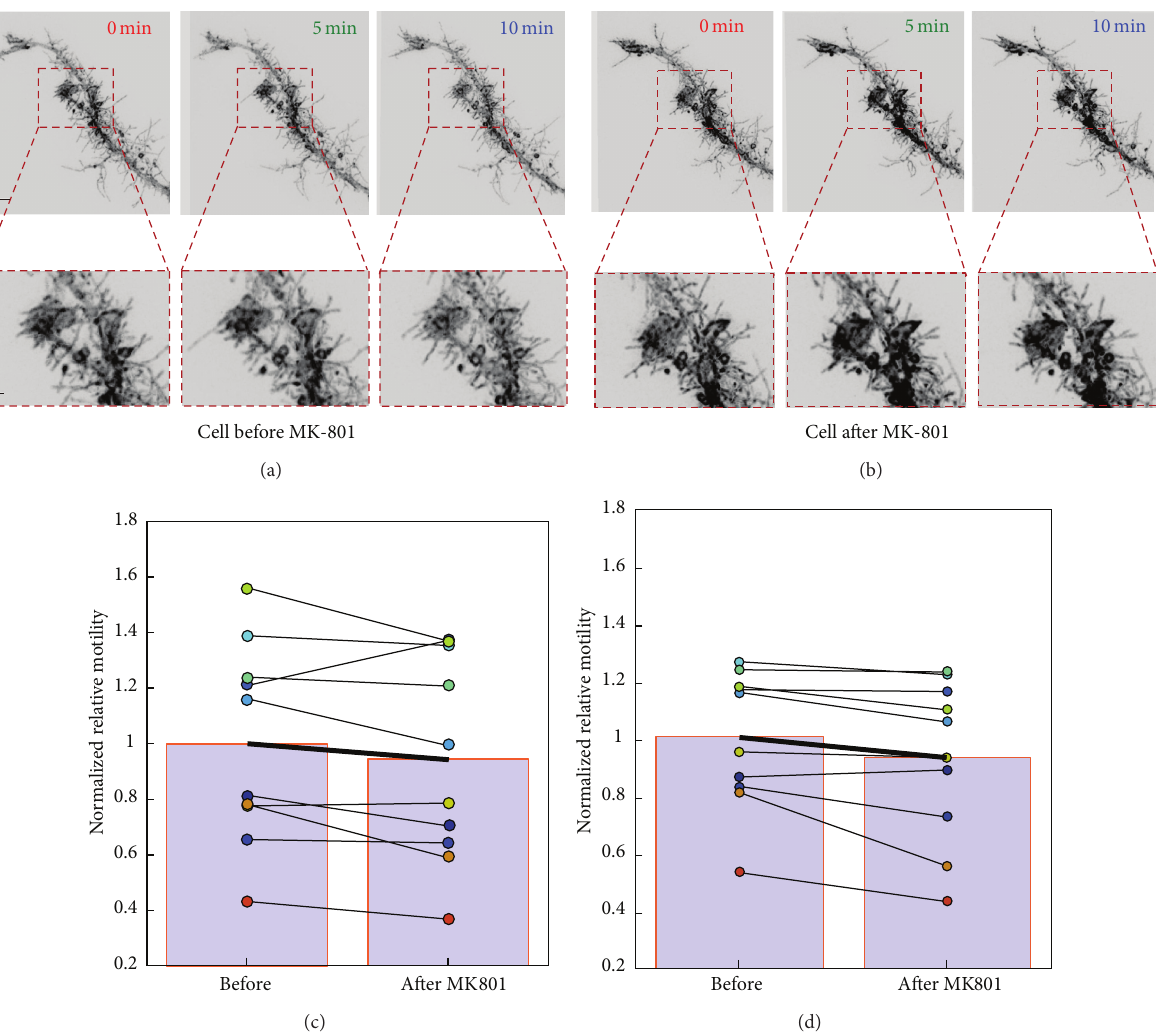
Figure 5: Comparing the relative sensitivity of the two motility measurement methods using images of normal radial glia cells ( 𝑁 = 10 ) before and after injection of 100 𝜇 M MK-801 into the ventricle of the tadpole to reduce motility. ((a), (b)) Example of glial motility before (a) and after (b) drug treatment. (c) Motility index changes measured using Method 1 from [15]. (d) Results using the boxcar-based Method 2. Each individual cell is depicted with the same color in (c) and (d). Note that Method 2 gives more consistent results. All values are normalized to the mean predrug motility index to facilitate comparison. Scale bar = 10 𝜇 m in upper panel and 2 𝜇 m in lower panel of